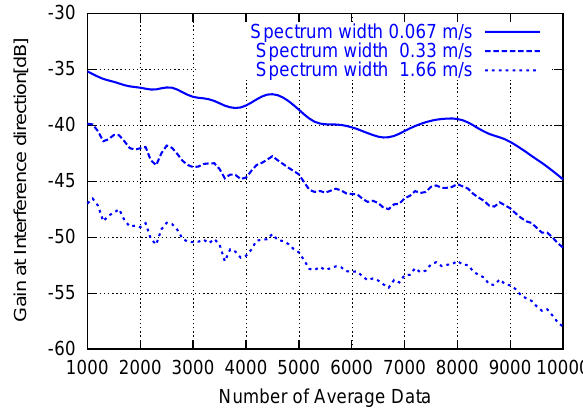
Fig. 11. Gain in direction of interferer for signals with different spectral width when no mean motion is